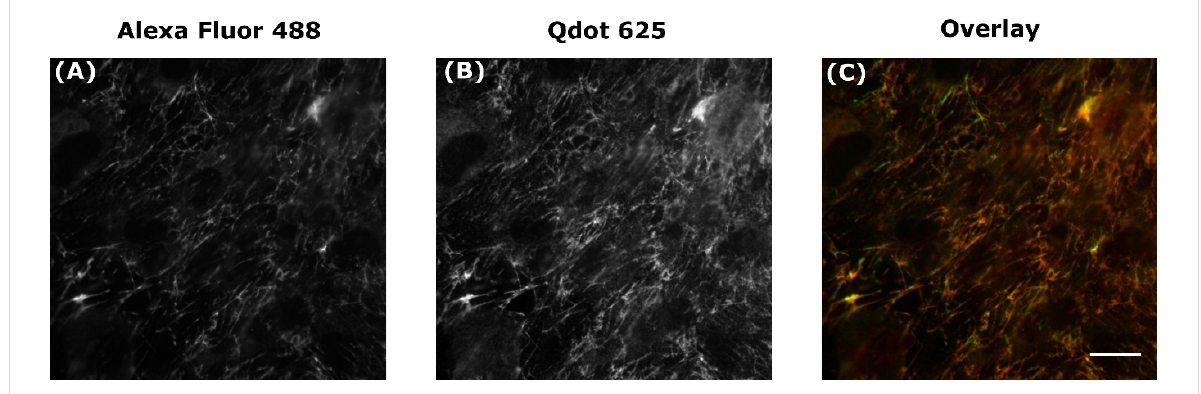
Figure 2: Specific labelling of fibronectin with Qdots. Fixed rat mammary (Rama) 27 fibroblasts were dual labelled with green Alexa Fluor 488 (A) and a red Qdot 625 (B) to produce an overlaid wide-field image (C). Scale bar is 20 μ m.